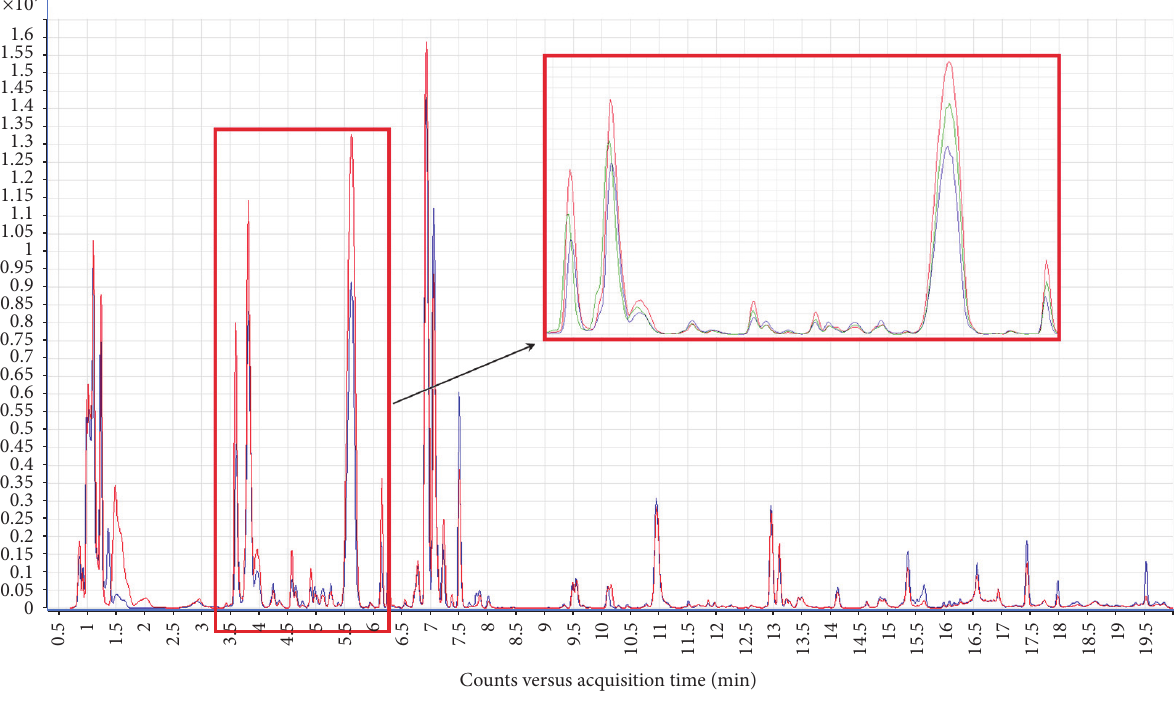
Figure 1: Total compound chromatograms obtained for AH samples extracted with different volumes of methanol :ethanol. Aqueous humor samples were prepared by addition of one AH volume to one (red), two (green), or three (blue) volumes of methanol : ethanol and analyzed with 20 min